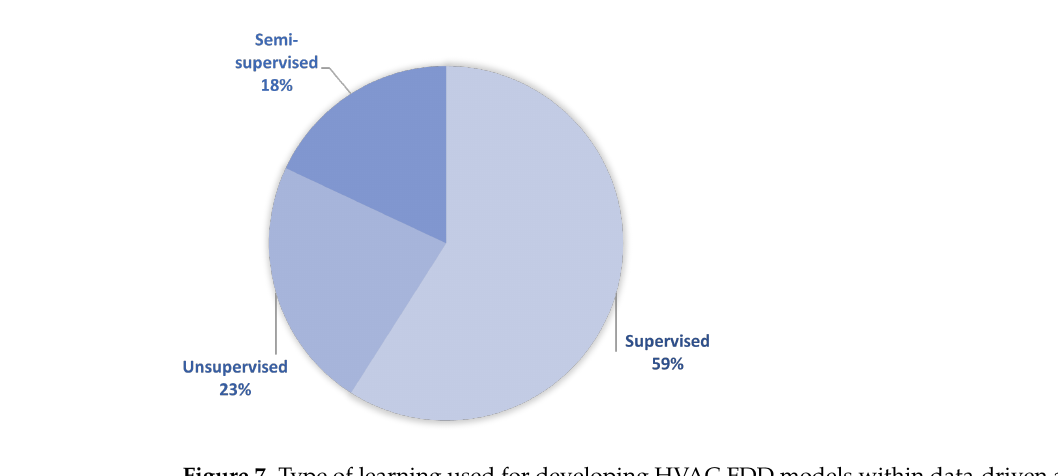
Figure 7. Type of learning used for developing HVAC FDD models within data-driven and hybrid approach. Table 4. Supervised learning used in the research from the selected literature. If the record contains a certain value for Software , then it is actually a representative of a hybrid approach in which some of the data-driven techniques are implemented. For clarity, all acronyms are provided in the Abbreviations